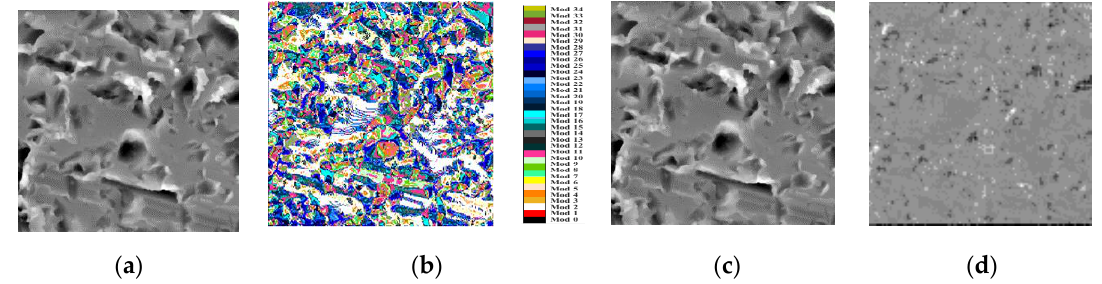
Figure 17. Relationship between the scale of analysis and the six surface categories compression performance by using the multiscale high-pass (HP) data sets.